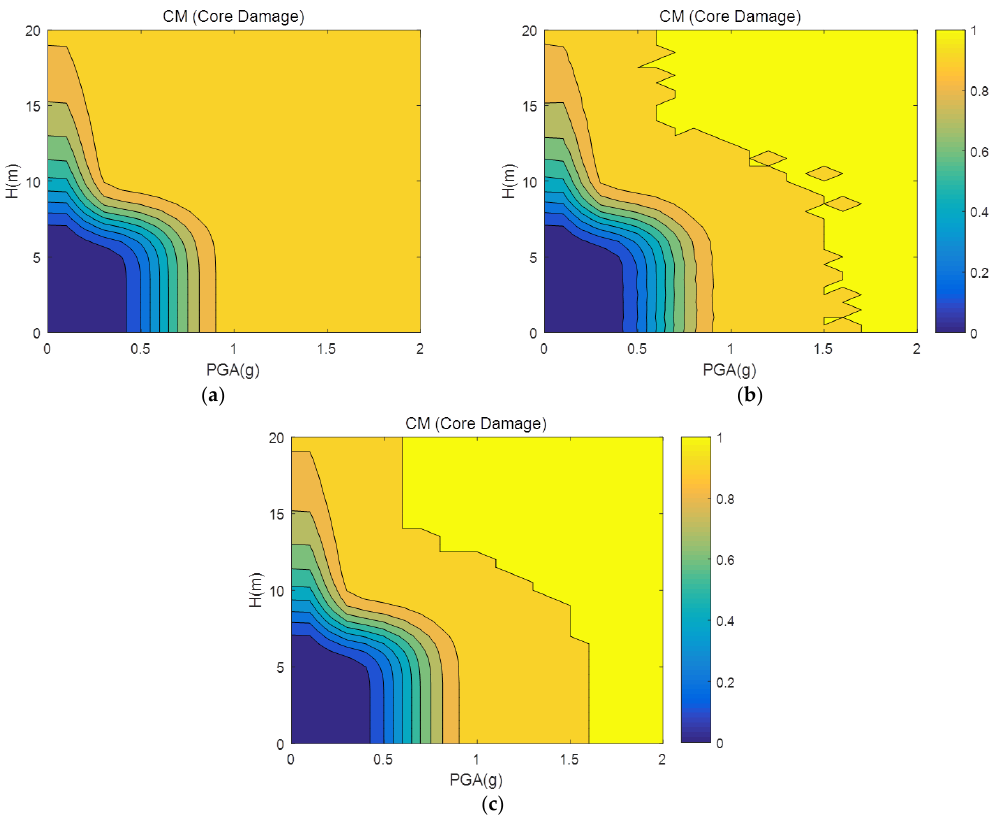
Figure 14. Comparison of multi-hazard system fragility results (“CM sequence”) regarding the LGS NPP example ((1) independent condition): ( a ) Boolean; ( b ) E-DQFM; ( c ) proposed (I-DQFM).